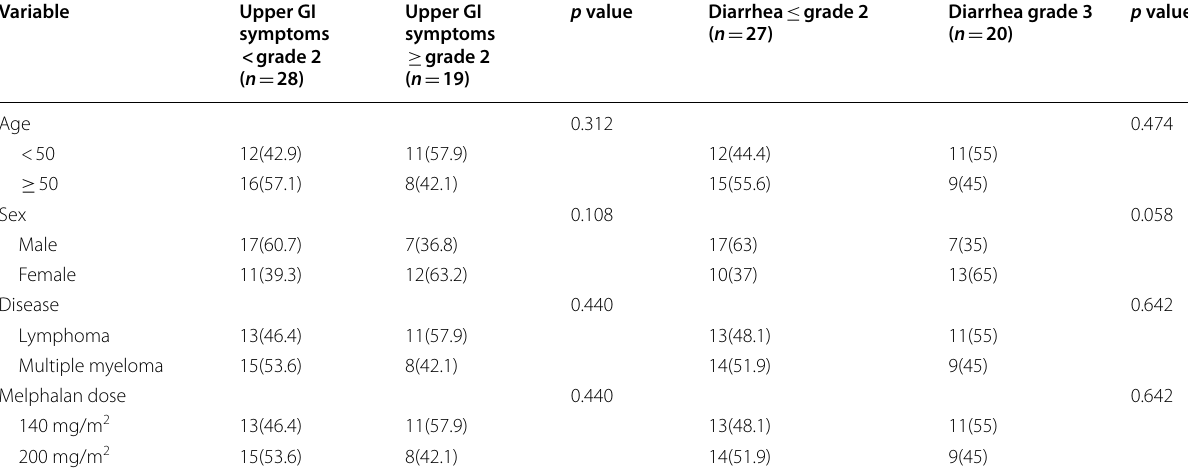
Values are expressed as median (range) and n (%)